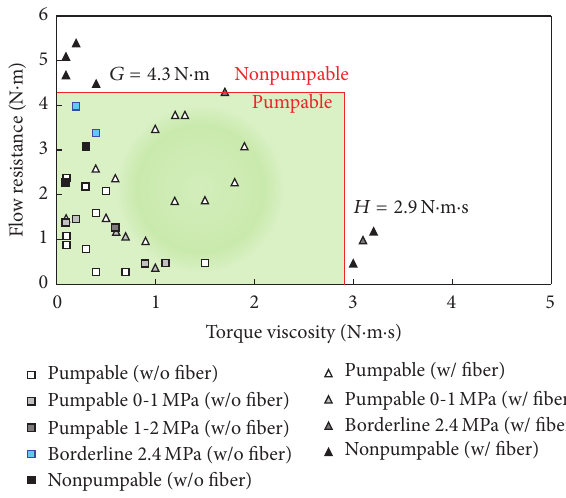
Figure 3: Rheological properties for different mixtures and their borderline values